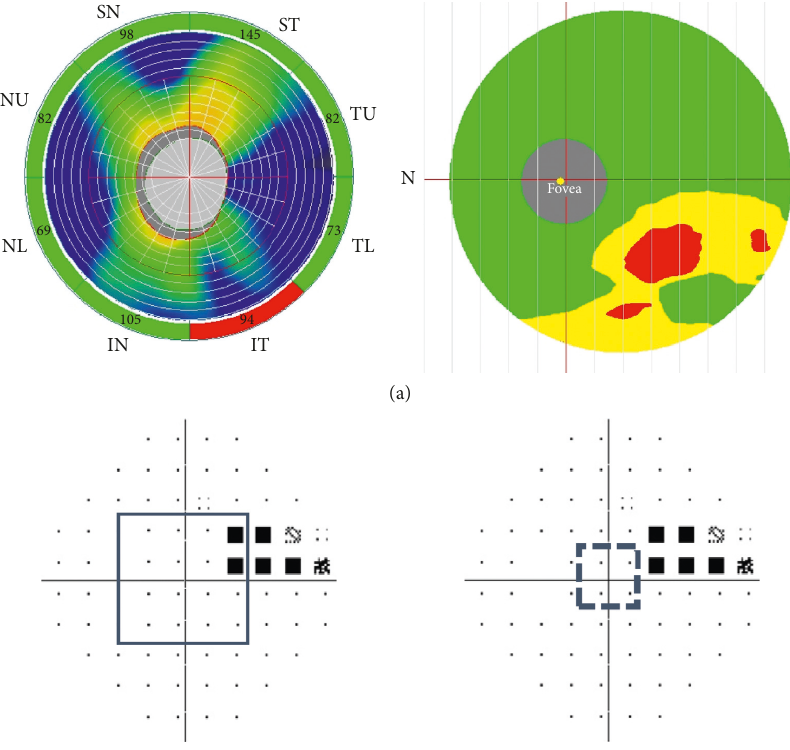
Figure 1: (a) A representative eye with glaucoma with superior hemifield defects measured by spectral-domain optical coherence to- mography (SDOCT). Circumpapillary retinal nerve fiber layer (cpRNFL) thickness map (left) and macular ganglion cell complex (mGCC) thickness map (right). ST: superior-temporal; TU: temporal-upper; TL: temporal-lower; IT: inferior-temporal; IN: inferior-nasal; NL: nasal- lower; NU: nasal-upper; SN: superior-nasal. (b) Evaluation of the central visual field defect. The VF defects correspond to the cpRNFL and mGCC maps at the top panels. In the pattern deviation plot of the visual field measured by the Humphrey field analyzer, the prevalence of significant ( P < 0 . 05) points in 16 points within central 10 degrees and 4 points within central 5 degrees is measured. (Left) The central visual field defect is defined because of at least 1 significant point lying in 16 points (squeal line) within central 10 degrees. (Right) The central visual field defect is not defined because of no significant point lying in 4 points (squeal dot line) within central 5